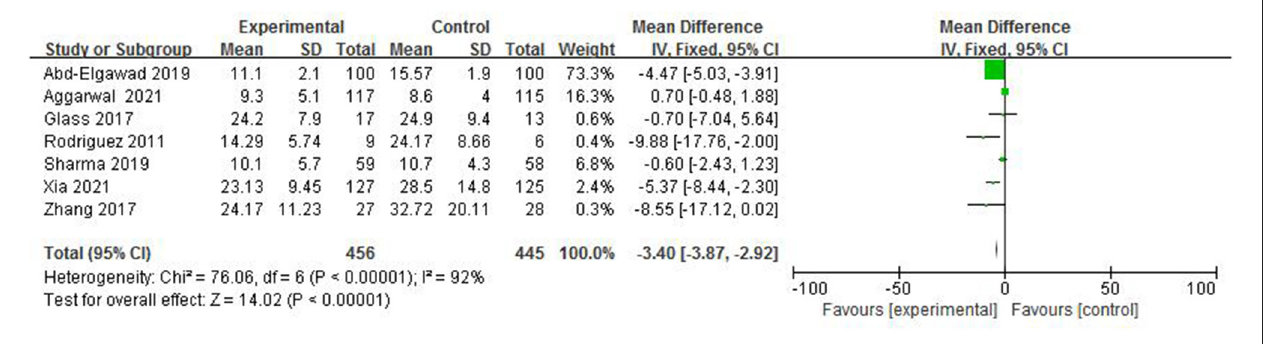
FIGURE 7 | Forest plot of time to reach full enteral